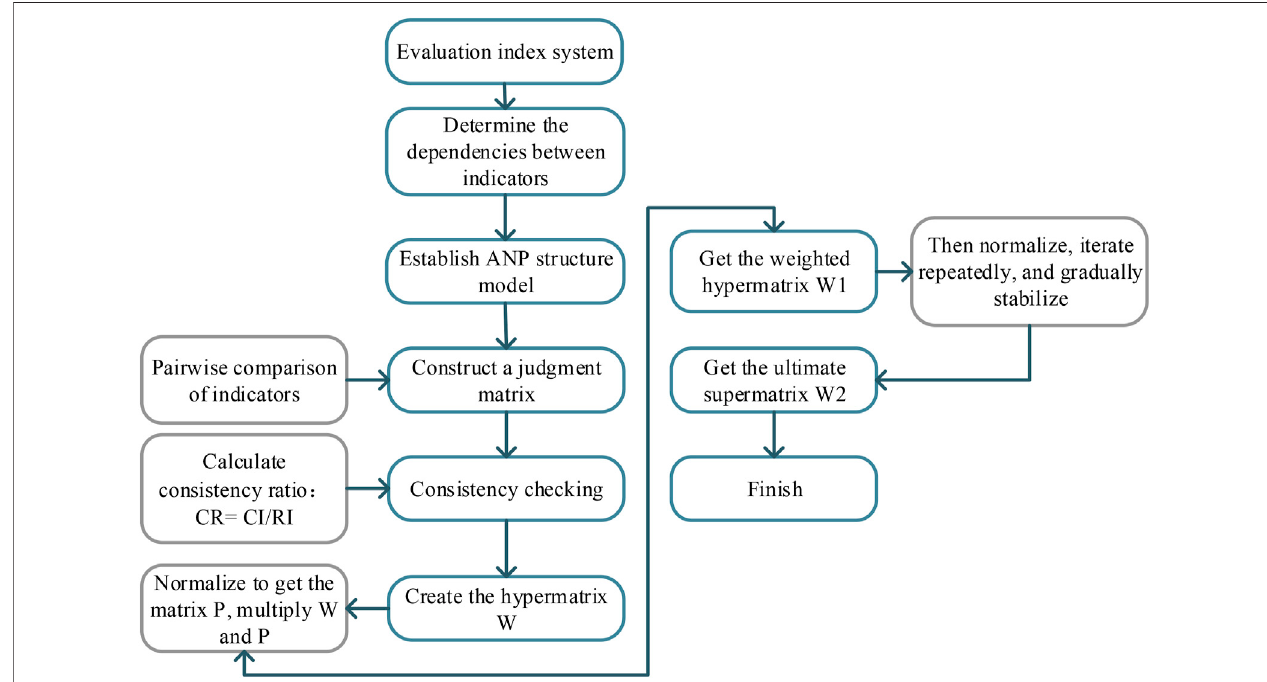
FIGURE 1 | ANP fl owchart.